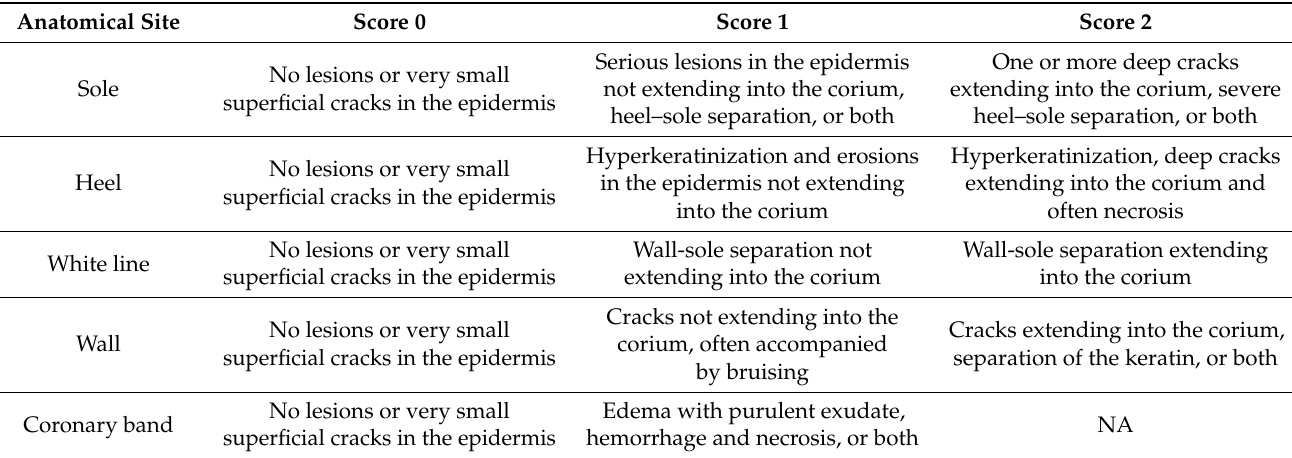
Table 1. Scoring system applied for evaluation of